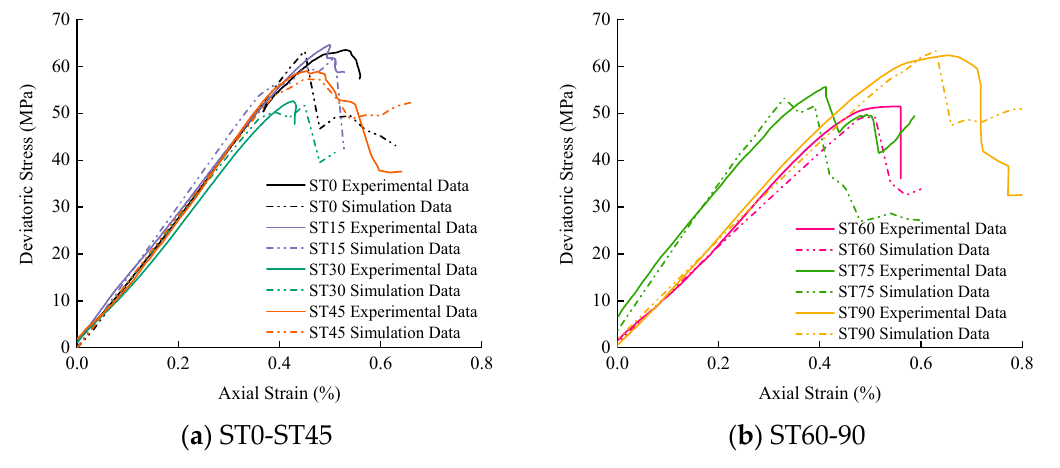
Figure 11. Comparison of test and simulation results of stress-strain curve of T-shaped fracture specimen.